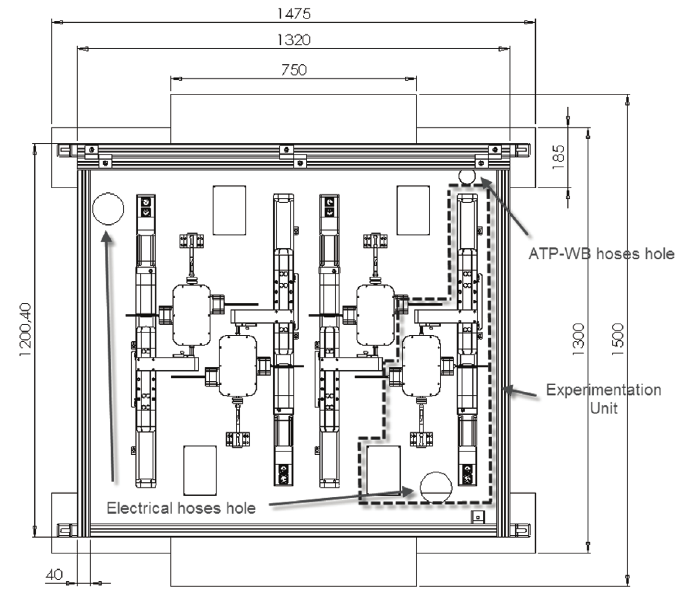
Figure 1. Main experimental rack. The designed electromechanical system was composed of three racks. In this figure a scheme of the main rack is presented, containing the four experimentation units. One of the four experimentation units is highlighted with a dashed line. Several electrical holes permitted connection to all electrical components in the main rack (sensors, actuators, linear engines, resistances). One ATP-WB hole permitted access to liquid conductions transporting ATP and Wash Buffer to each experimentation units. Lengths are expressed in